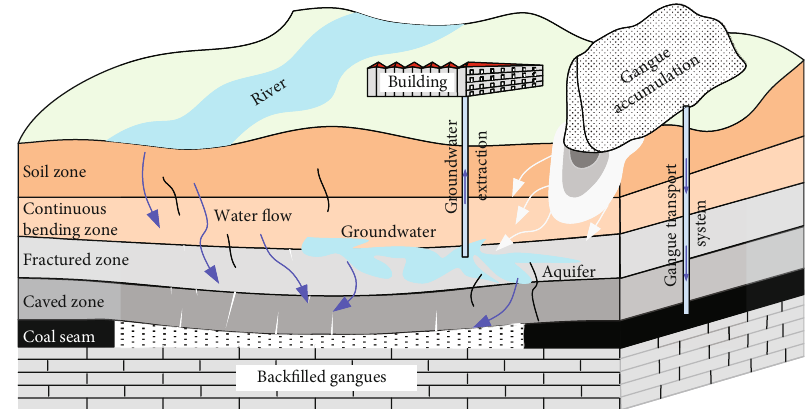
Figure 2: Coal seam groundwater runo ff roadmap.